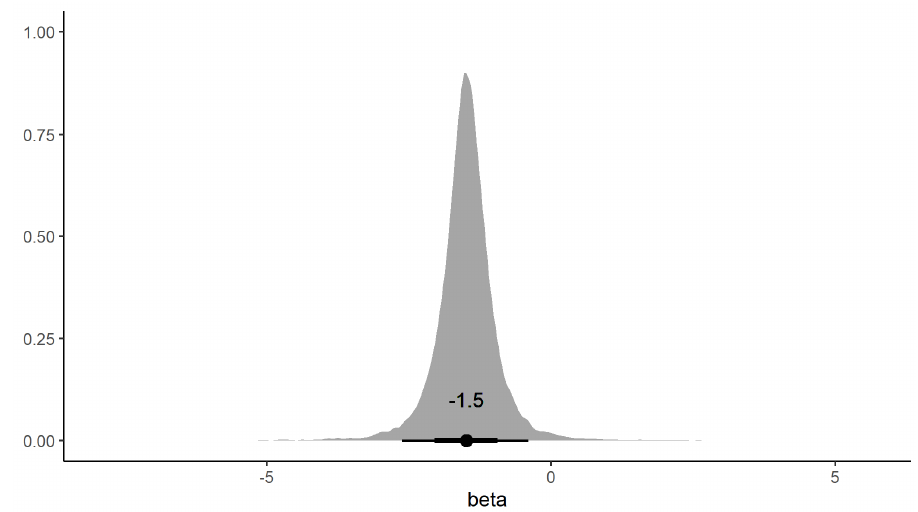
Figure 11. The density of the beta coefficient defining the relationship between the RHDV2 population size and RHDV1 population size (see Equation (1)). The dot on the black bar is the posterior median, the thick bar the 80%, and the thin bar the 95% credible intervals.